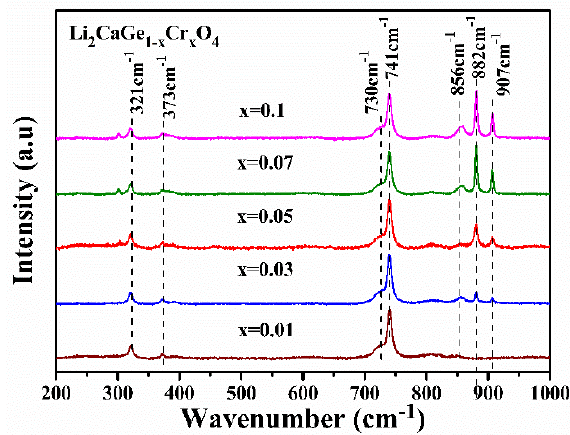
= 0.01, 0.03, 0.05, 0.07, and